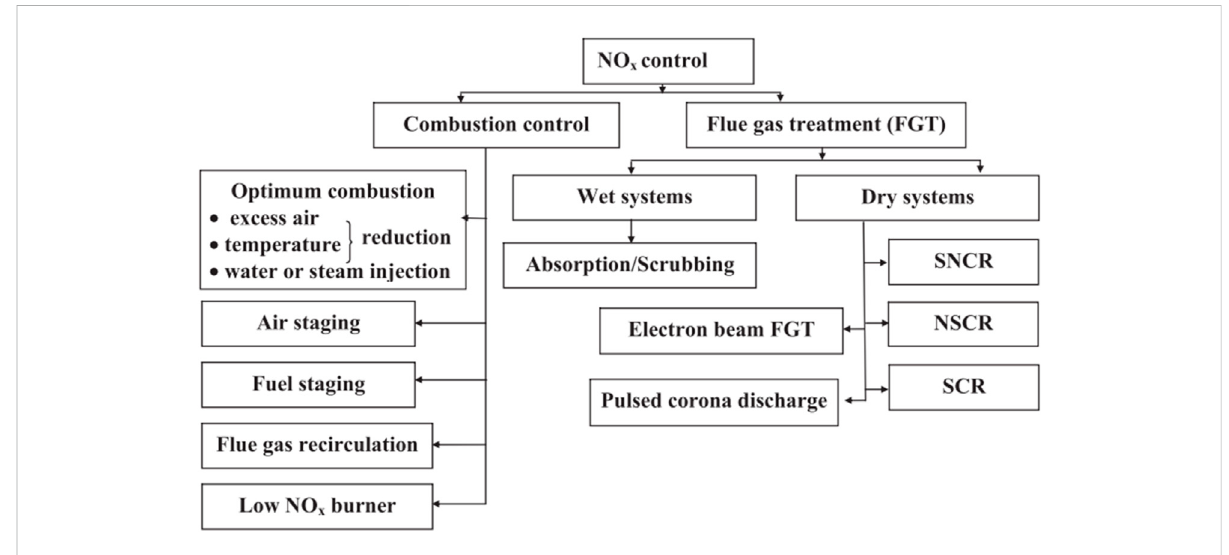
FIGURE 1 Overview of NO X removal technology (Mladenovi ć et al.,